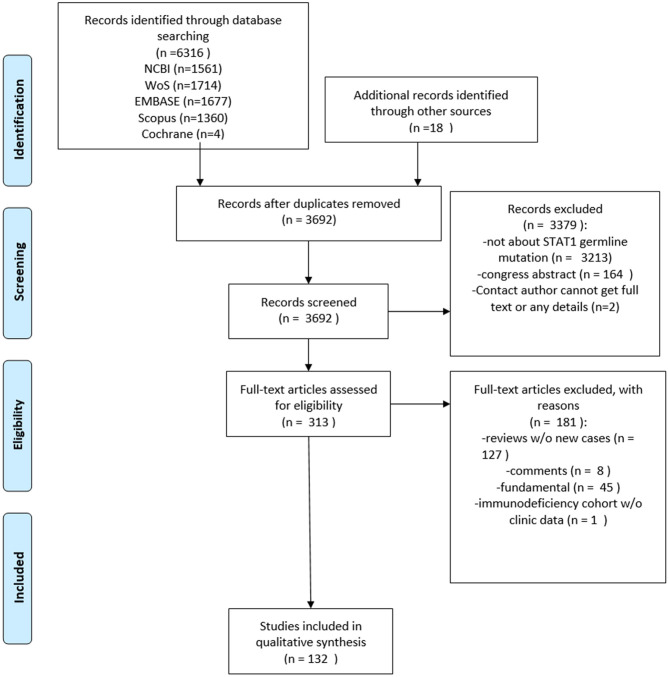
PRISMA flow diagram.